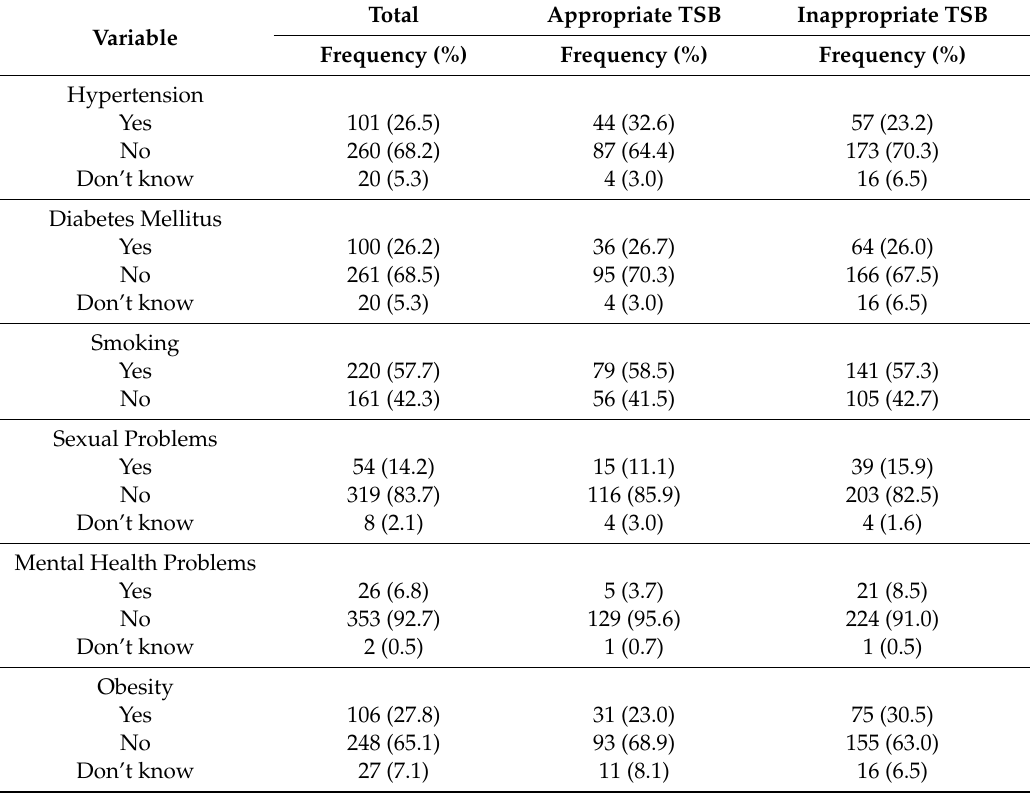
Table 4. Reported morbidities among participants based on TSB ( n =